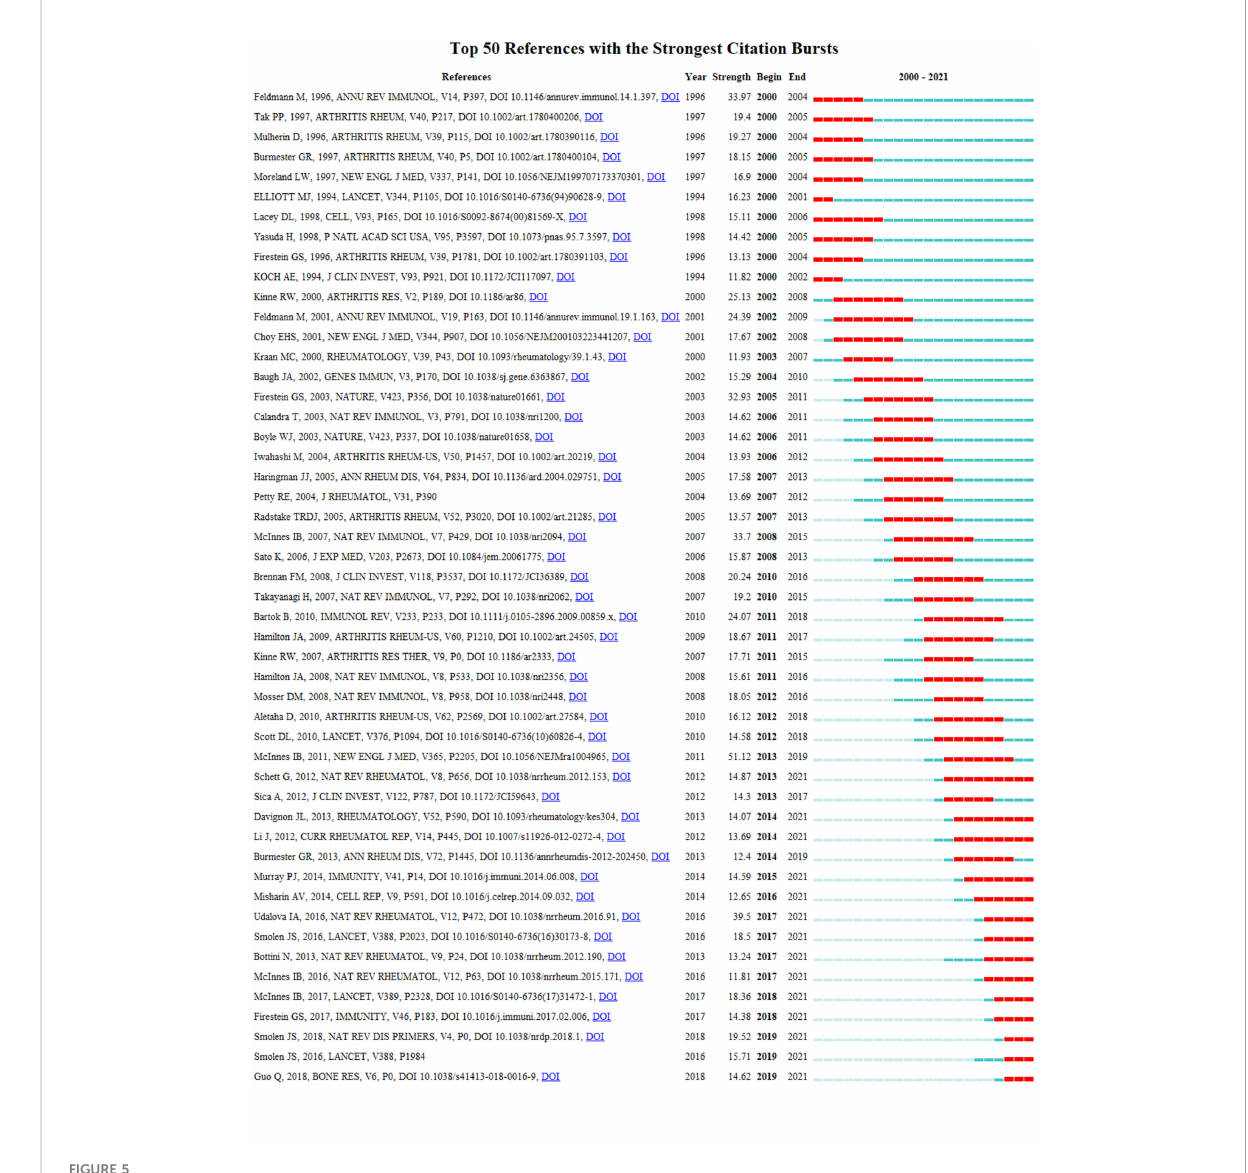
FIGURE 5 Visualization map of top 50 references with the strongest citation bursts involved in macrophage-related